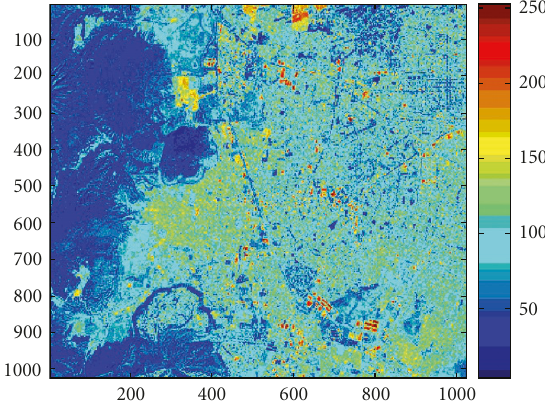
Figure 10: Original test scene represented in MATLAB pseudocolor